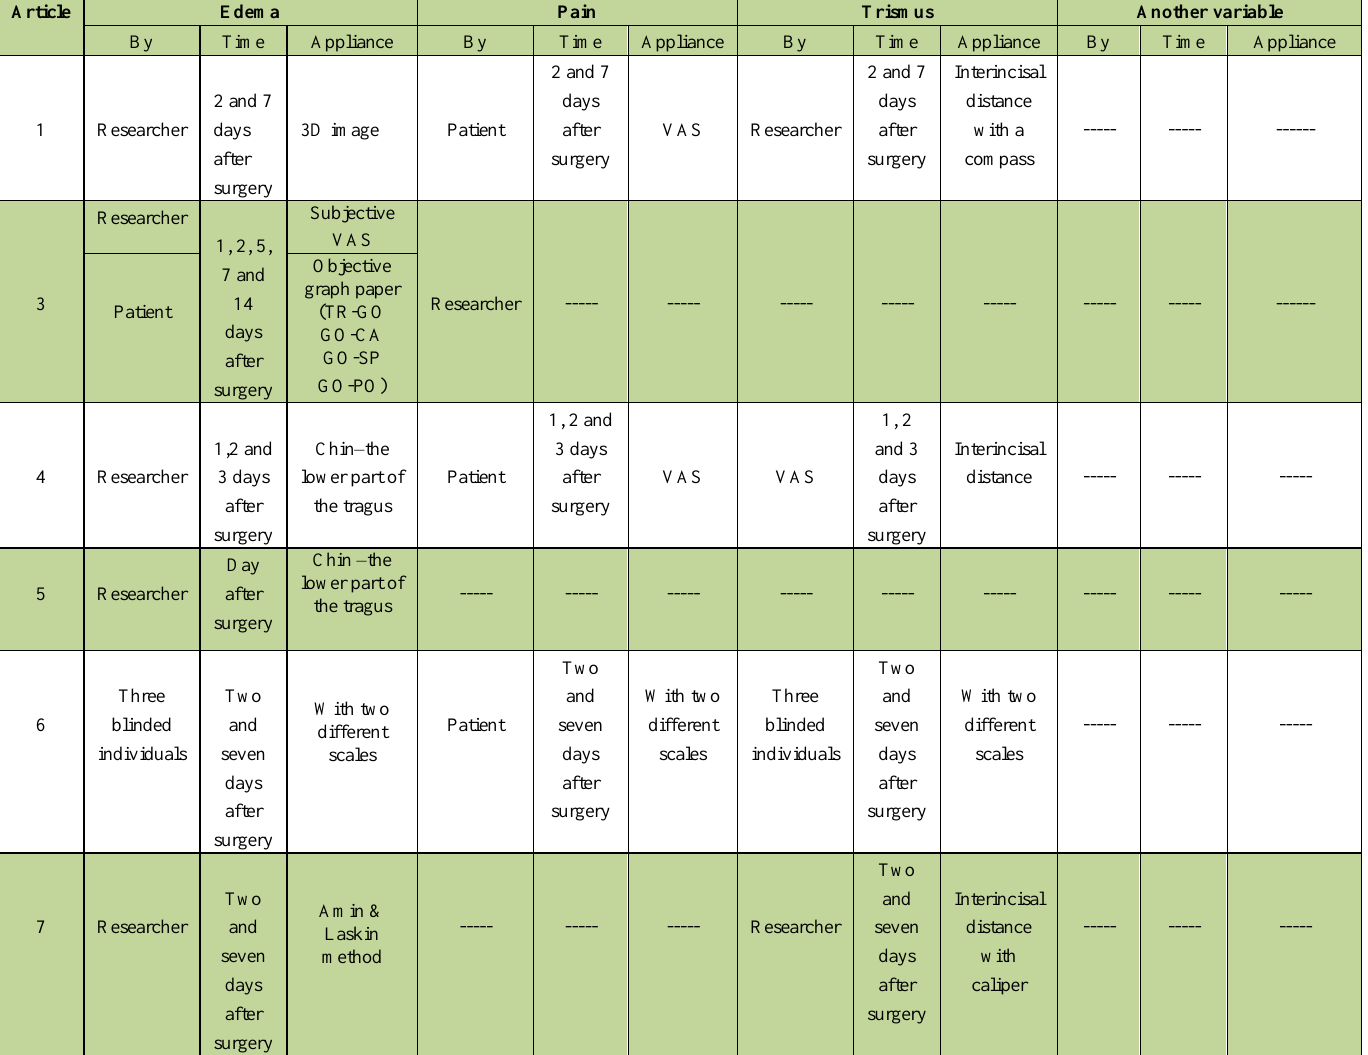
Table 4: Assessment Of Post-Operative